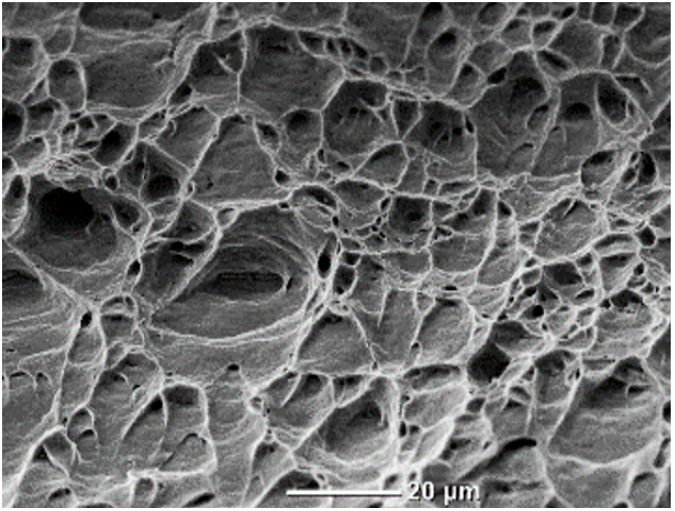
Figure 17. SEM analysis of 1050 aluminium at 1000×.